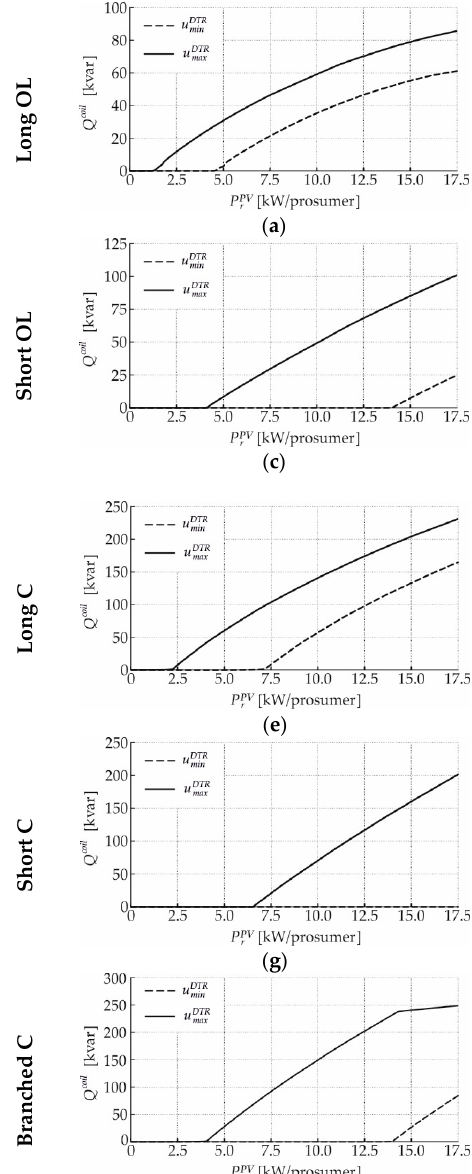
Table A2. Control parameters for the di ff erent LV test-feeders and control strategies.